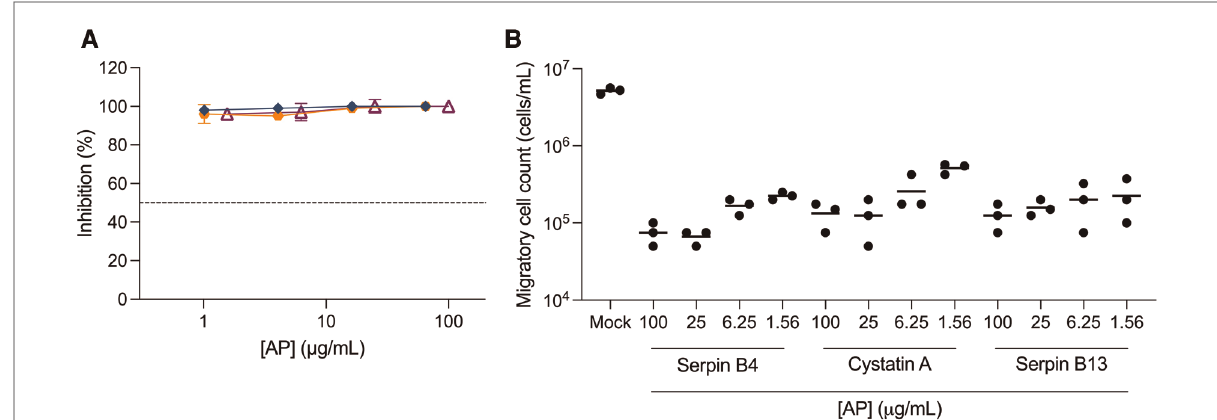
FIGURE 3 Inhibition of trans- infection by antiproteases. Ecto-cervical explants were treated with antiproteases (APs), serpin B4 ( ), cystatin A ( ), serpin B13 ( ), prior to viral challenge and after four washes with PBS, transferred to new plates. Migratory cells were harvested after 24 h of culture and were either ( A ) transferred to 96-well plates containing PM-1 cells or ( B ) counted in a total volume of 200 μ L. Co-cultures with PM-1 cells were kept for 15 days. The concentrations of p24 in the harvested supernatants were quanti fi ed by ELISA and the extent of inhibition calculated. The percentage of inhibition was normalized relative to the p24 values obtained for cultures not exposed to virus (0% infectivity) and for cultures infected with virus in the absence of compound (100% infectivity). Dashed line represents 50% of inhibition. Data are means (± SEM) from three independent experiments performed in